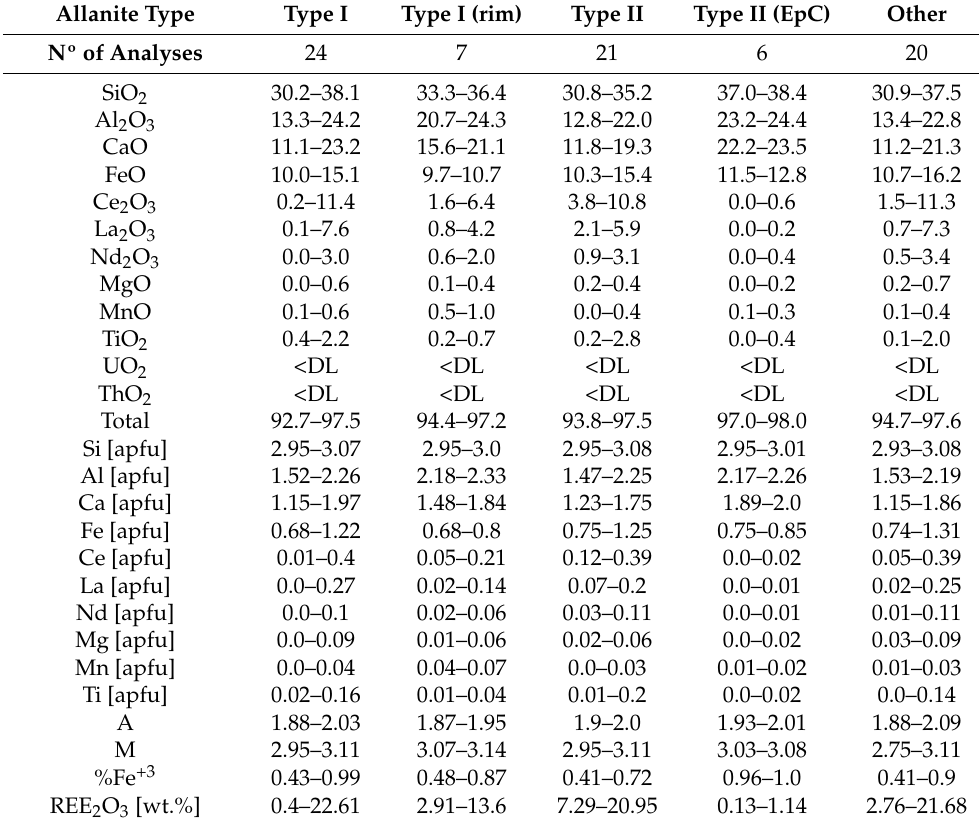
Table 1. Range of chemical compositions obtained by EPMA of defined allanite